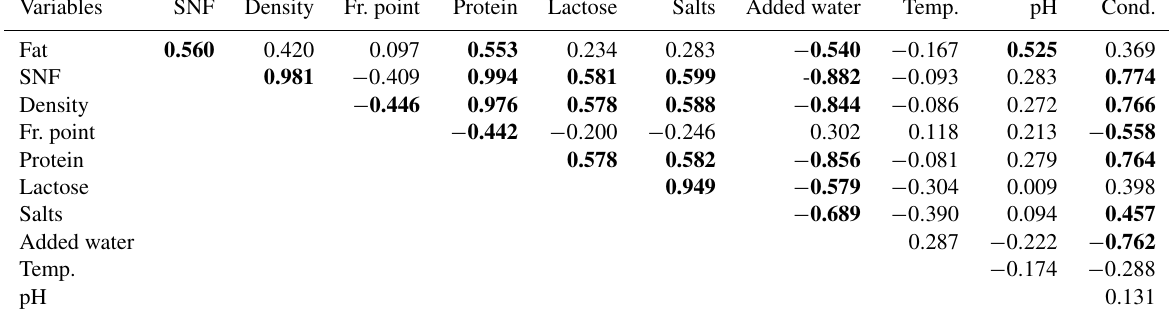
Table 5. Milk mineral content in two different farms during the observed period. Bold values represent a correlation between parameters at p < 0 . 05.